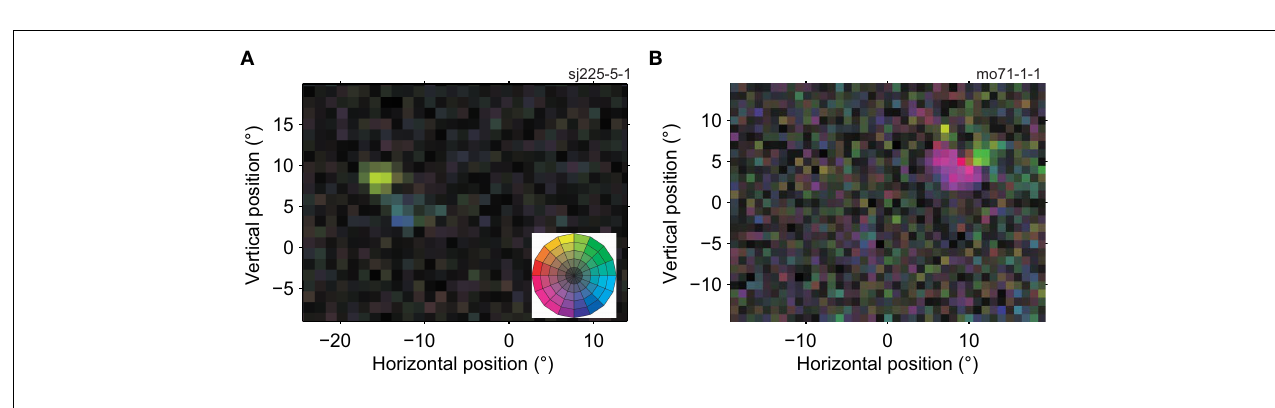
(11,450 spikes; 15min; L -ratio = 0.001). (B) This neuron preferred left and downward (purple) and upward (light green) motion in two adjacent regions of its RF (6413 spikes; 14.4min; L -ratio = 0.057).These RF maps show that direction preference of neurons in MT depended on the location within the receptive